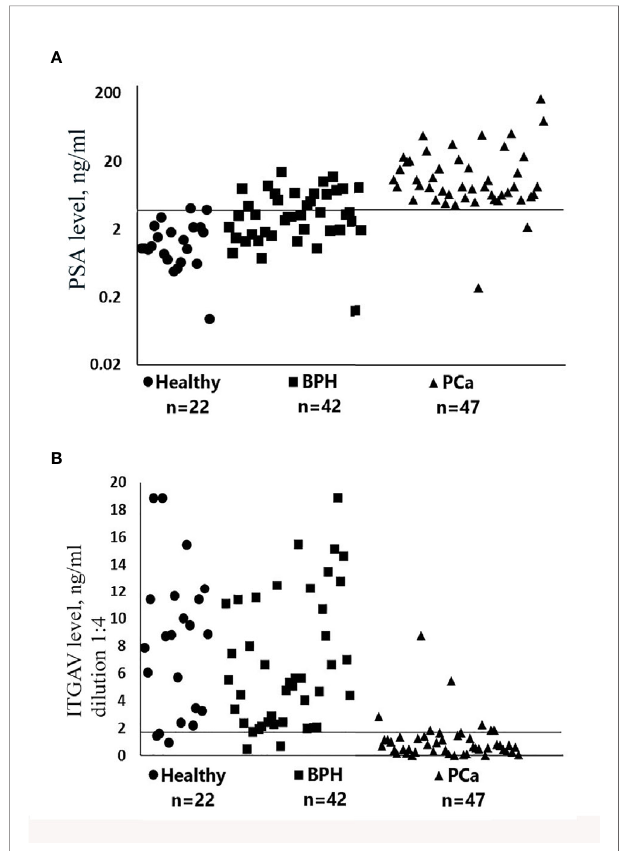
FIGURE 2 | Scatter plots representing serum prostate-speci fi c antigen (PSA) (A) and urinary Integrin alpha V (ITGAV) (B) concentrations determined by enzyme-linked immunosorbent assay (ELISA). The number of samples (n) for each group of subjects is shown. Patient group abbreviations are described in Table S1 . The line on each scatter plot indicates a cutoff value of 4 ng/ml for serum prostate-speci fi c antigen (PSA) (A) and 2 ng/ml for urinary ITGAV (B) . Samples of urine for the detection of ITGAV were diluted 1:4 as described in Materials and Methods